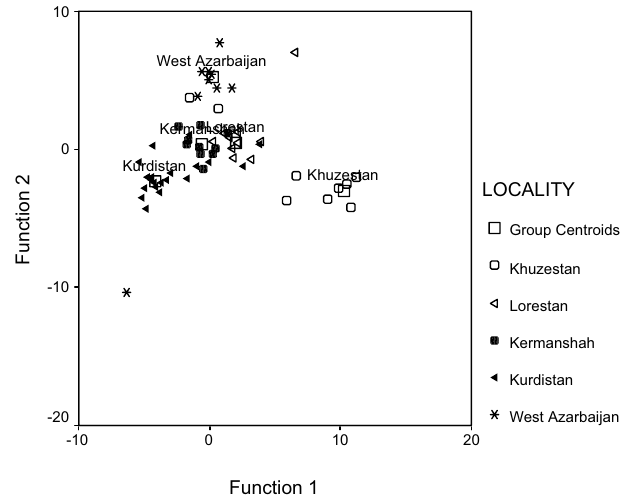
F IG 3.- Pattern of variation expressed by the two canonical variates for individuals of five populations of the genus Trachylepis on the discriminant